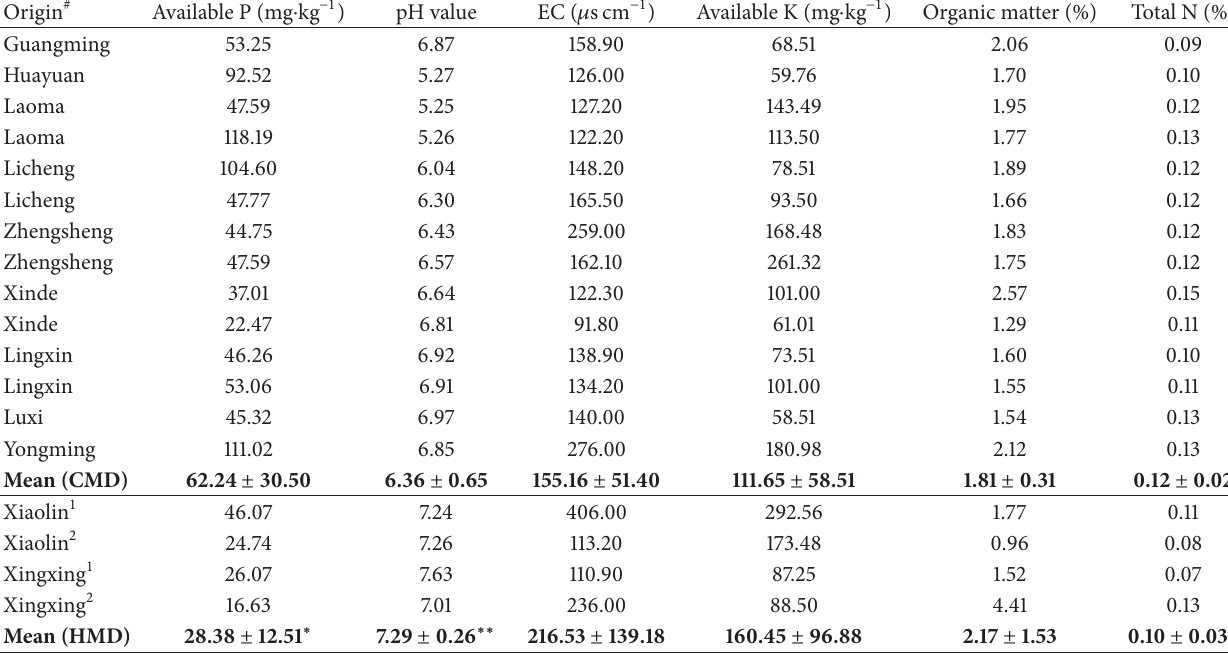
Table 3: Soil characteristics in HMD- and CMD-growing